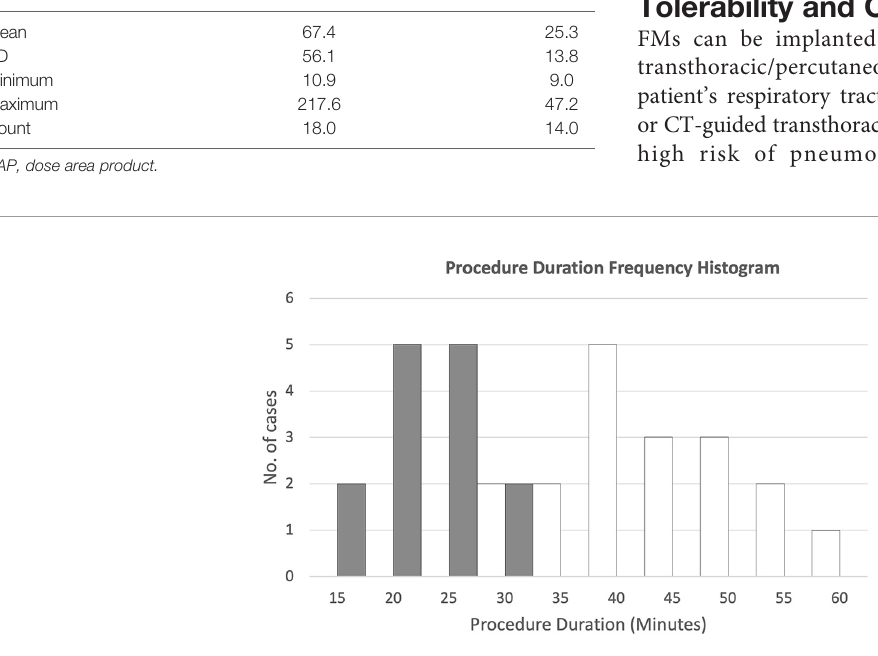
FIGURE 7 | Procedure duration frequency histogram for both groups of